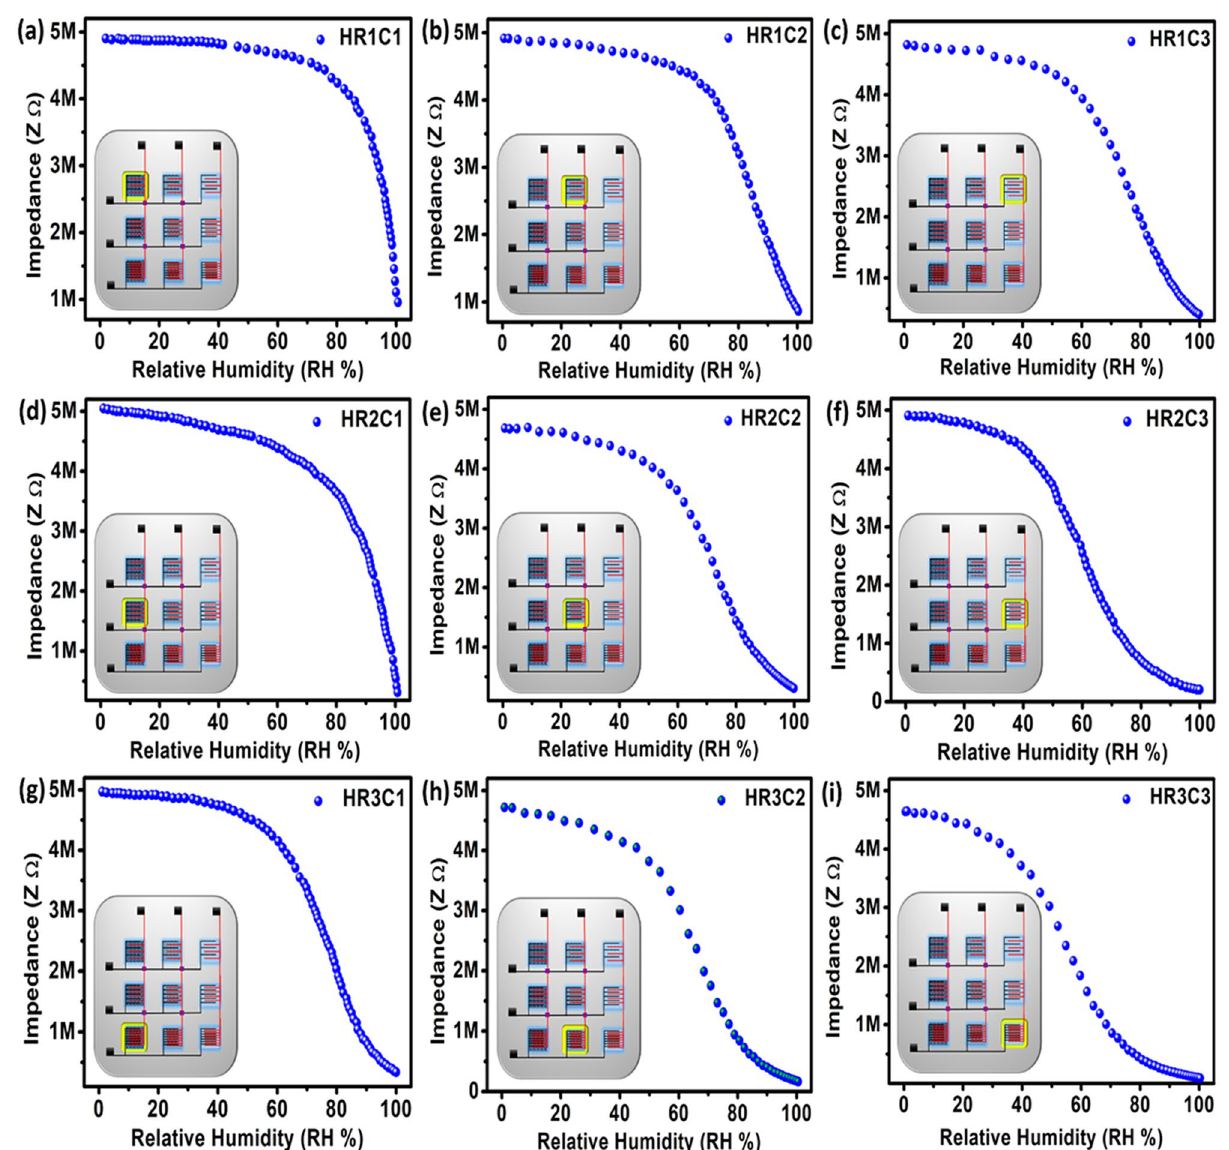
Figure 3. The 3 × 3 humidity sensing array showing sensors as following row 1 ( a ) HR1C1, ( b ) HR1C2, and ( c ) HR1C3 with 300 μm spacing. The row 2 contain following sensors ( d ) HR2C1, ( e ) HR2C2, and ( f ) HR2C3 with 200 μm spacing. The row 3 contain following sensors ( g ) HR3C1, ( h ) HR3C2, and ( i ) HR3C3 with 100 μm